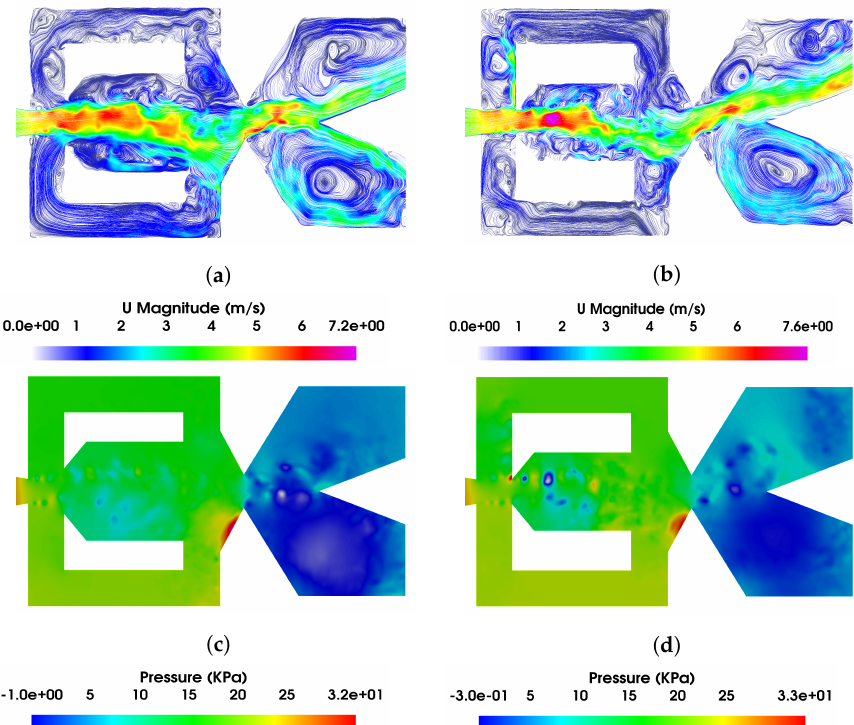
Figure 4. Fluidic oscillator internal velocity field ( a , b ), and pressure magnitude ( c , d ). Maximum inlet width ( a , c ), minimum inlet width ( b , d ). Reynolds number